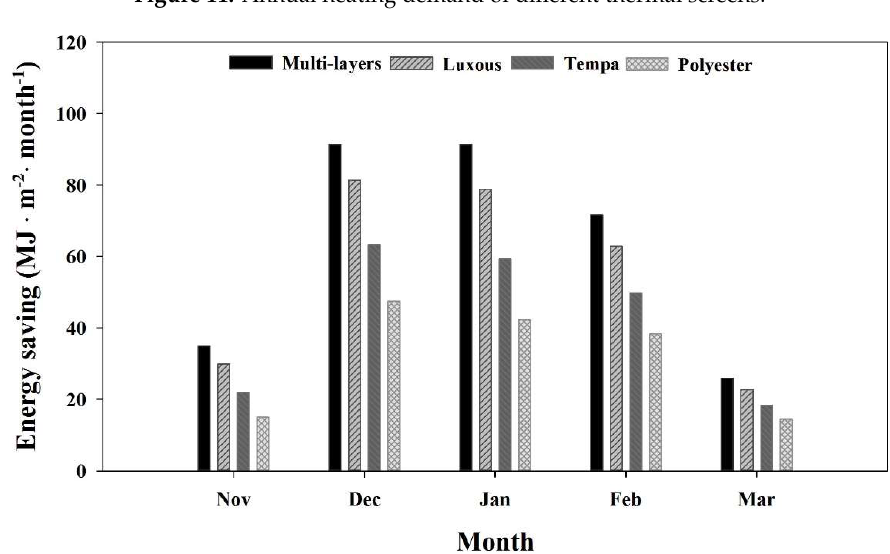
Figure 12. Energy saving potential of di ff erent thermal screens.